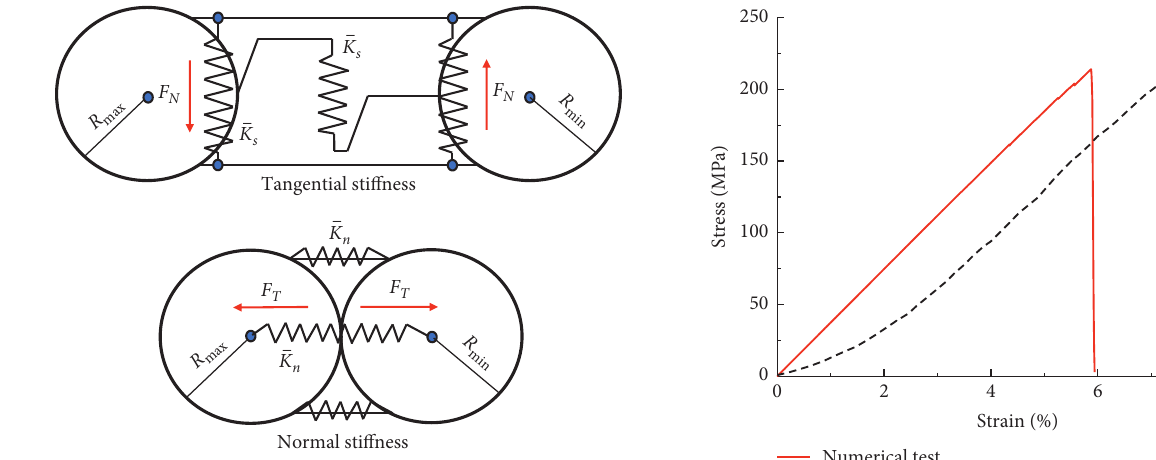
Figure 2: Sketch map of parallel bond model. Table 1: Meso-mechanical parameters of sandstone physical mechanics.